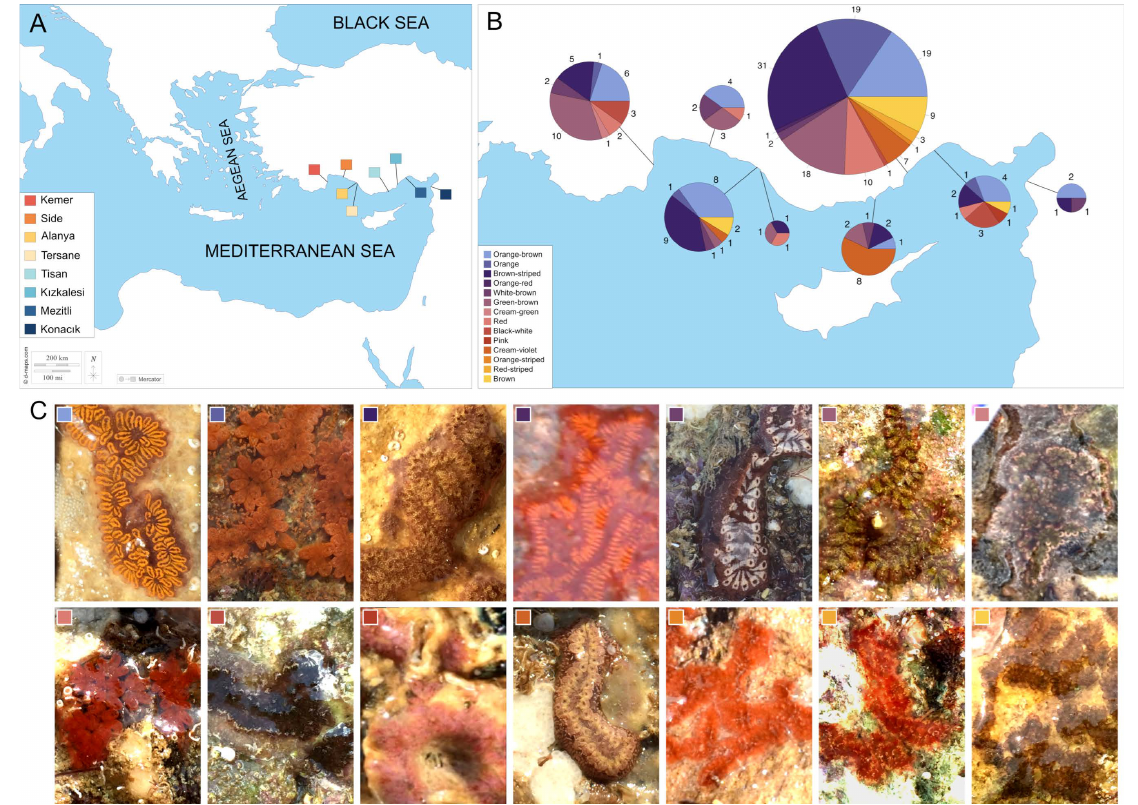
Figure 1. Morphotypes of Botrylloides niger from the sampling stations of the NEMS. ( A ) NEMS sampling sites, from west to east, cover the Antalya region (Kemer, Side, Alanya, Tersane), the Mersin region (Tisan, Kızkalesi, Mezitli) and the Hatay region (Konacık). ( B ) Regional diversity in the sampled morphotypes, depicted with pie charts proportional to the sample sizes. ( C ) In situ images of the corresponding